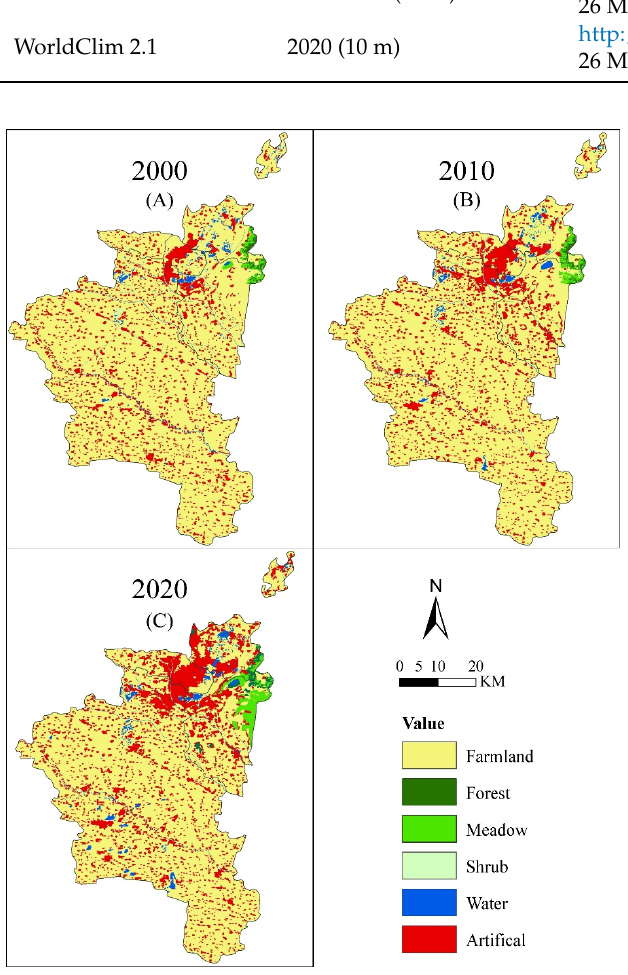
Figure 3. The land use map of Huaibei City from 2000 to 2020.The solid line in the figure is the administrative boundary line of Huaibei City